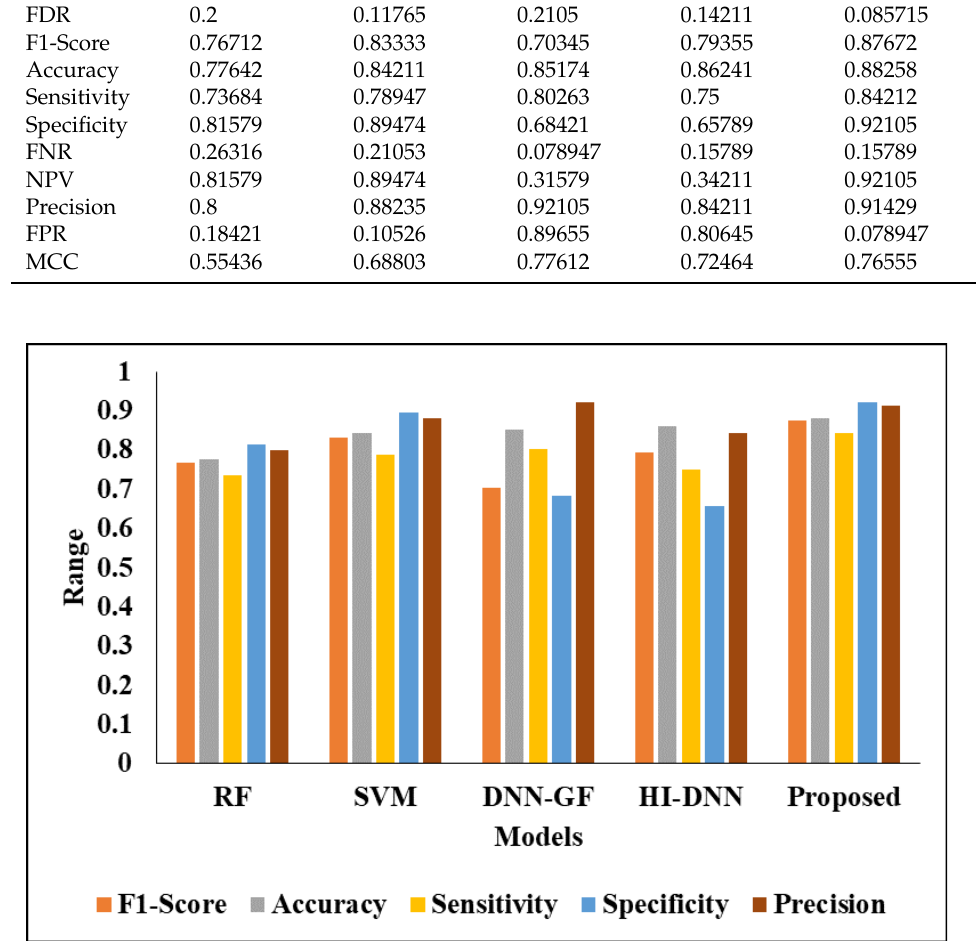
Figure 7. Analysis of the proposed model in terms of various